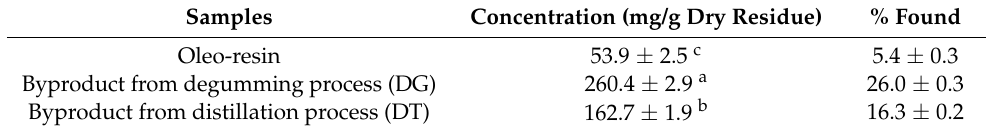
Table 3. Dipterocarpol content in oleo-resin and resin from different preparation processes.